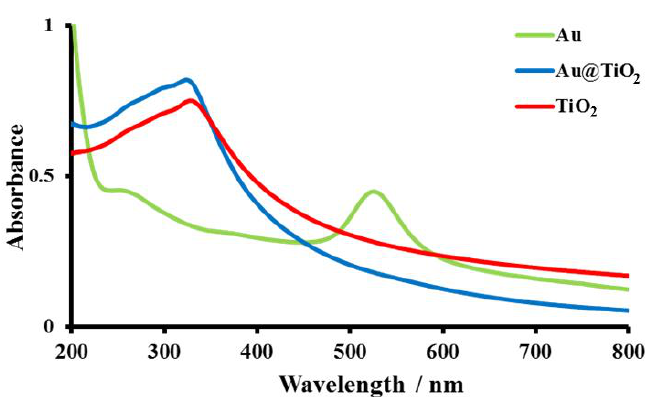
Figure 1. UV-Visible absorption spectra of AuNPs, TiO 2 and Au@TiO 2